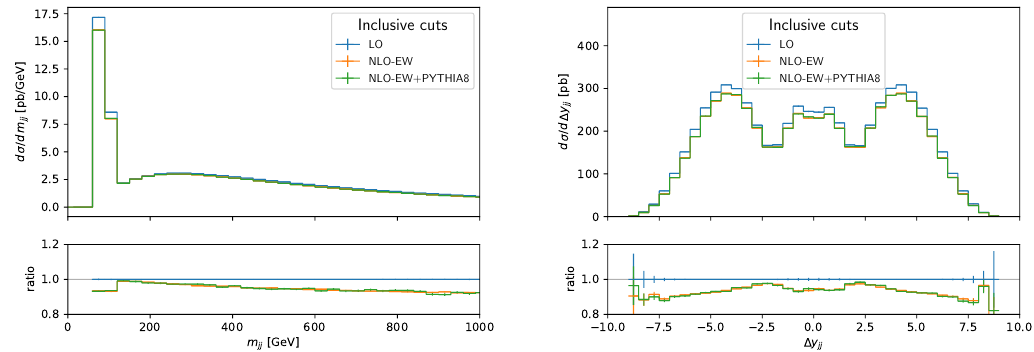
Figure 9 . Invariant-mass distribution of the two tagging jets (left) and their rapidity separation (right) at LO (blue), NLO-EW (red), and NLO-EW+PS (green) accuracy within the inclusive cuts of eqs. (3.3)–(3.4). The ratios of the NLO-EW+PS and the NLO-EW to the LO results are shown in the respective lower